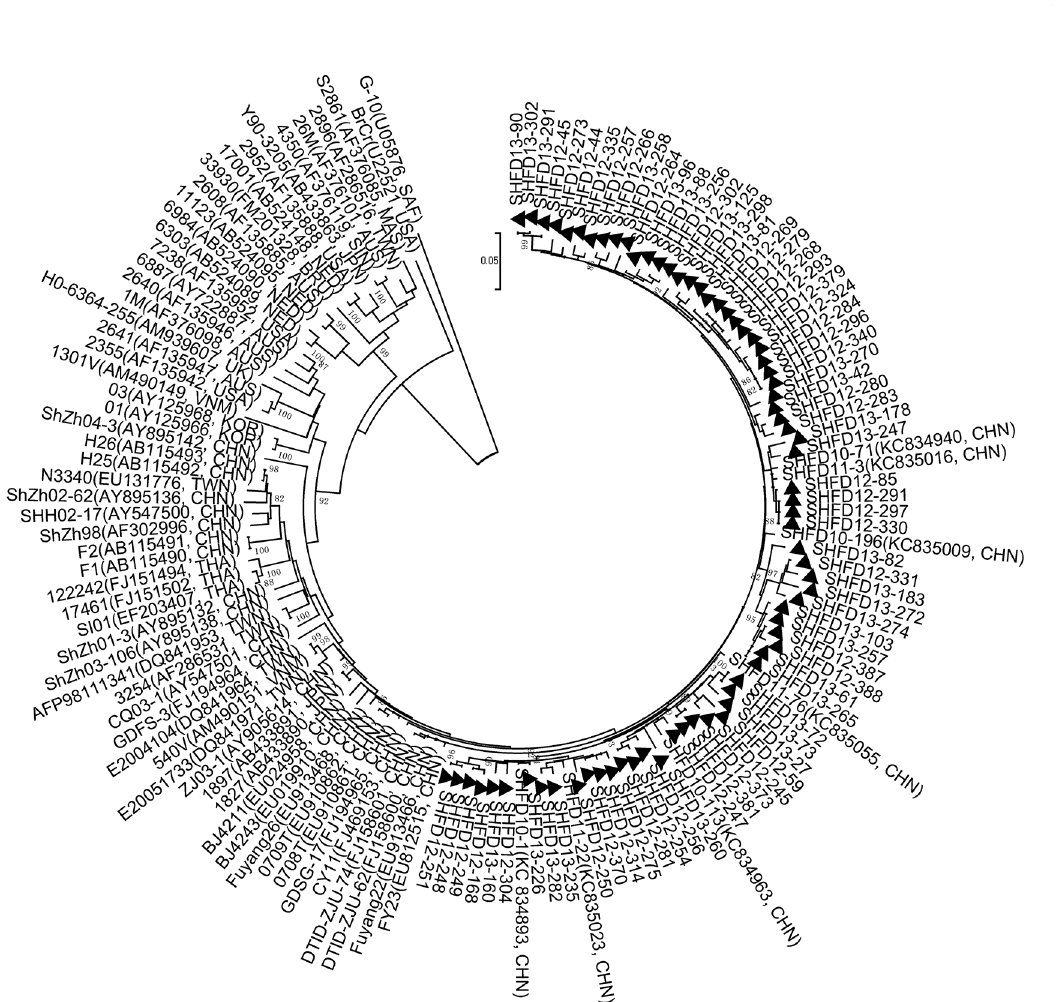
Fig 5. Phylogenetic analysis with the neighbor-joining method with a 1000-bootstrap re-sampling based on the alignment of the 468 nucleotide VP1 gene of 73 Shanghai EV71 strains. The strains labeled with ▲ were obtained in our